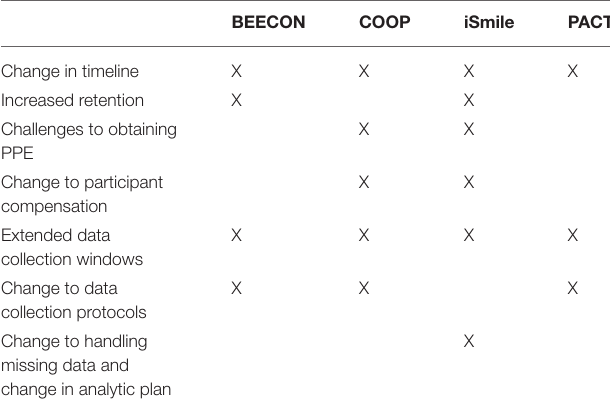
TABLE 1 | Overview of challenges by domain for the 4 OHDC Consortium trials. BEECON COOP iSmile